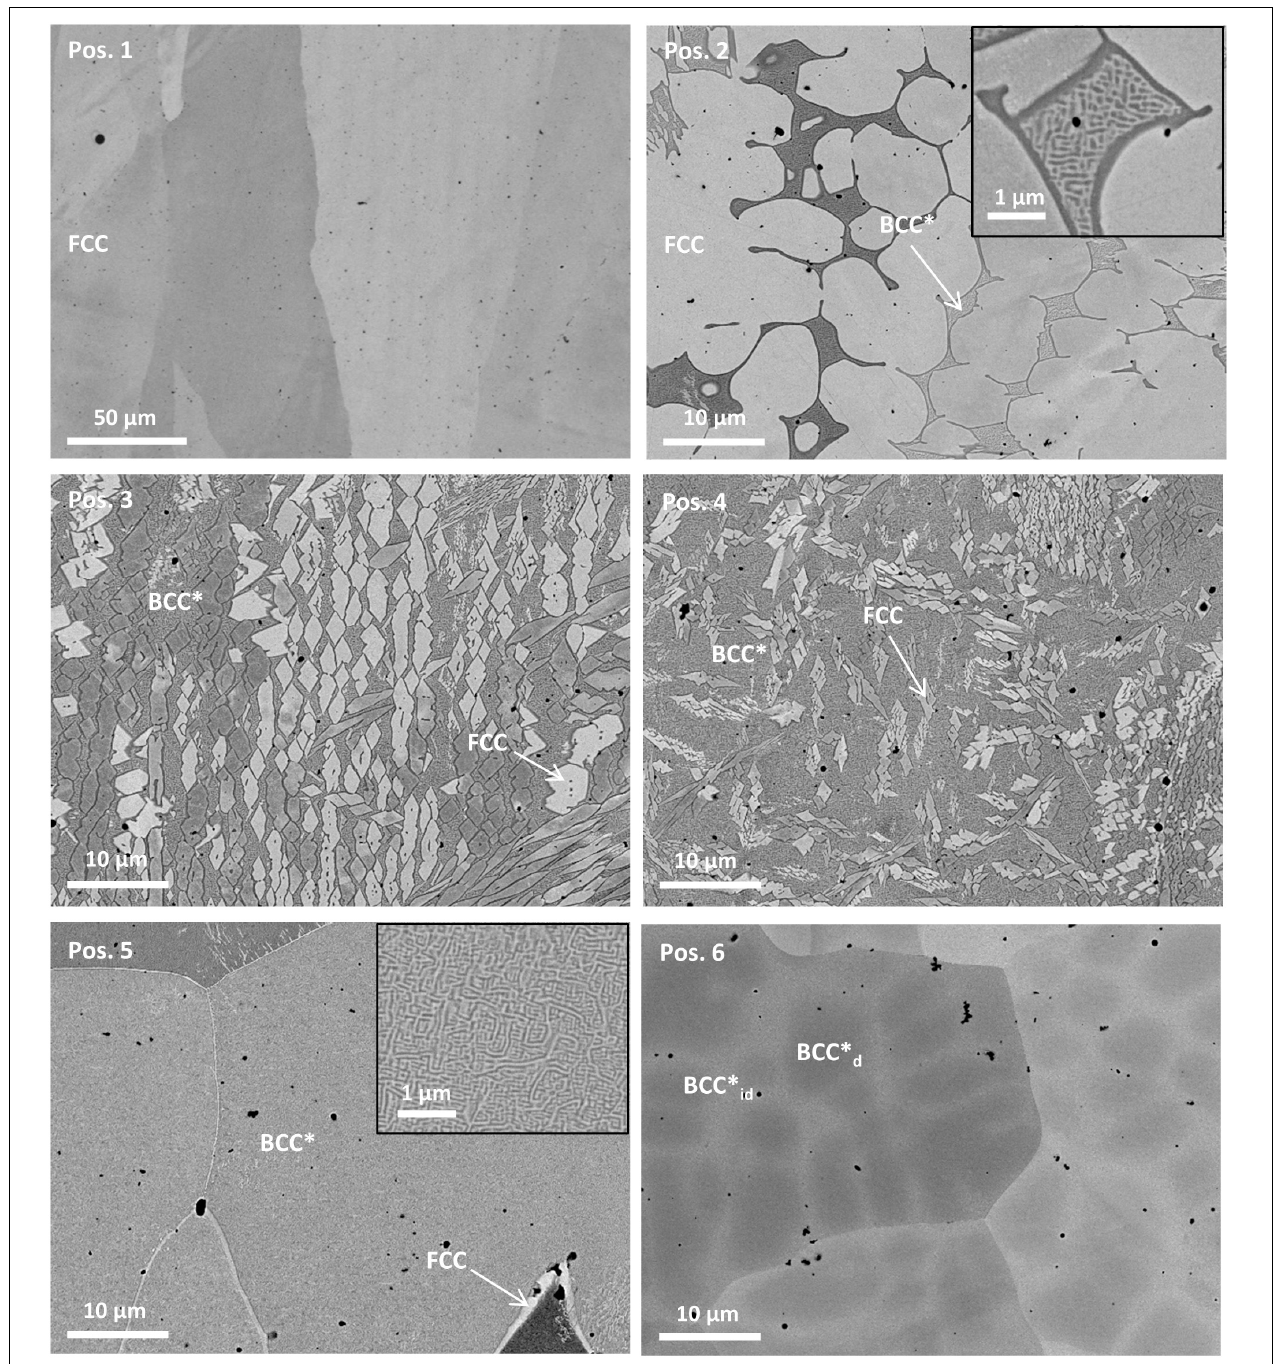
FIGURE 6 | SEM images of the major microstructures of the as built samples with increasing Al content derived from all three cladded gradients: Pos. 1 at 5.0 at% Al, Pos. 2 at 10.6 at% Al, Pos. 3 at 13.0 at% Al, Pos. 4 at 13.4 at% Al, Pos. 5 at 14.2 at% Al, and Pos. 6 at 25.8 at% Al.